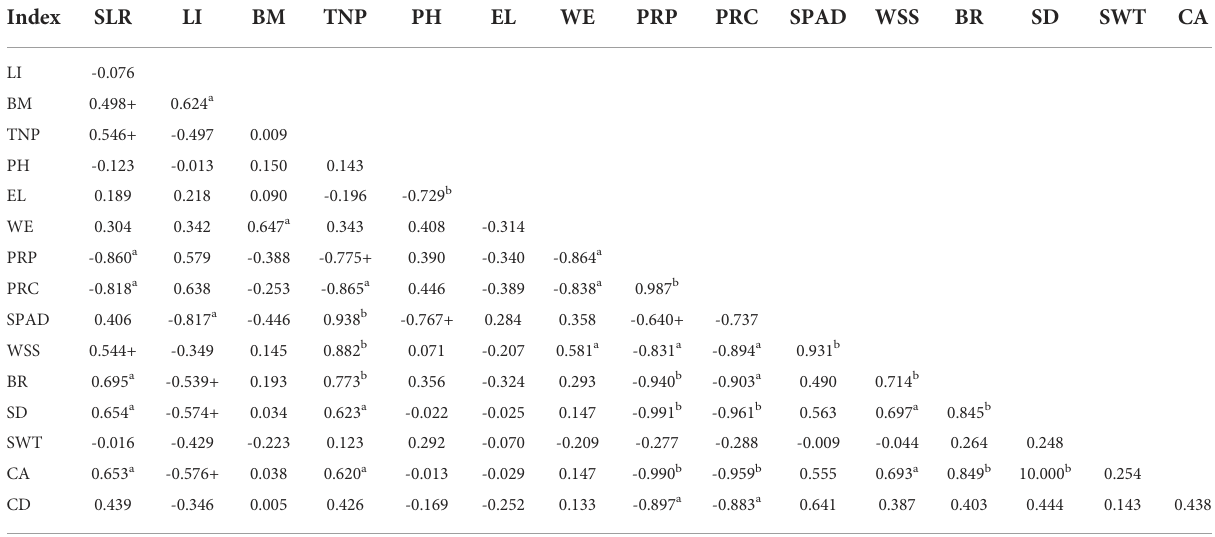
TABLE 1 Relationships among the physical indicators of rice stem under soil-testing formula fertilization using organic fertilizer for 11 years.